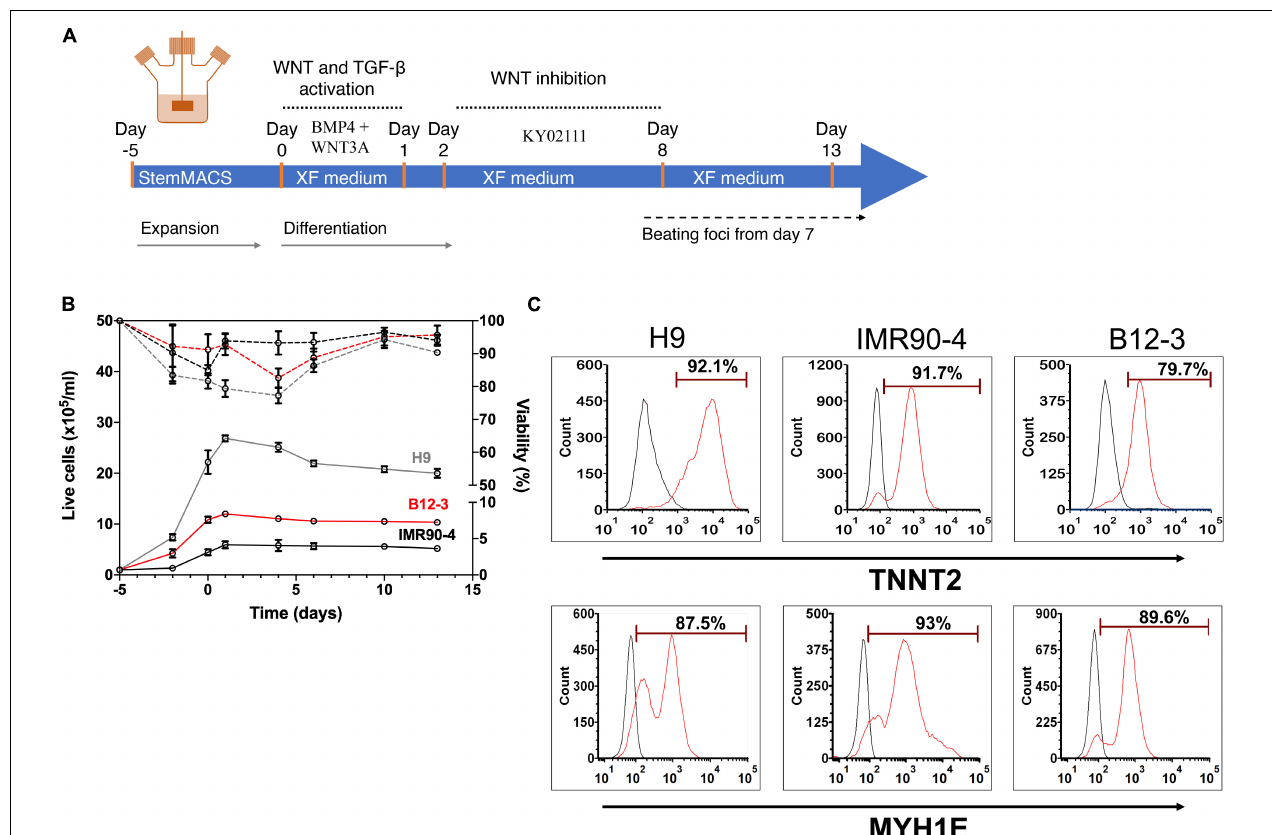
FIGURE 4 | (A) Schematic of the hPSC differentiation process in stirred suspension culture. (B) Cell proliferation and viability of hPSCs expanded for 5 days and subsequently differentiated toward CMs. Both steps were carried out in spinner flasks. Solid lines represent live cell concentration and dashed lines represent viability. A representative run is shown. H9, gray curves; B12-3, red curves; IMR90-4, black curves. (C) Flow cytometry analysis of populations derived from the three hPSC lines on day 13 of differentiation for expression of: TNNT2 – H9: 92.32 ± 1.67%, IMR90-4: 89.13 ± 2.61%, B12-3: 86.69 ± 1.14%, and MYH1E – H9: 84.61 ± 2.59%, IMR90-4: 93.7 ± 3.34%, B12-3: 87.62 ± 3.49% (mean ± SD from n ≥ 3). Representative graphs are shown. Sample, red curve; isotype, black